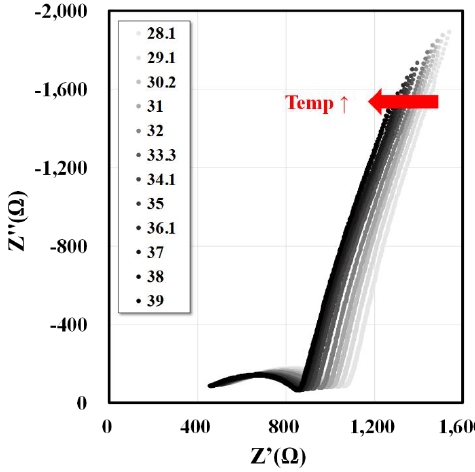
Figure 4. Whole blood impedance changes with increasing temperature (frequency range of 1 kHz to 30 MHz). The whole blood impedances were obtained at each temperature and graphed as Nyquist plots. The graphs show a tendency to move in the negative x-axis direction (arrow direction) as the temperature increases. The x-axis represents Z’ (resistance) of the impedance, and the y-axis represents Z’’ (reactance) of the impedance.